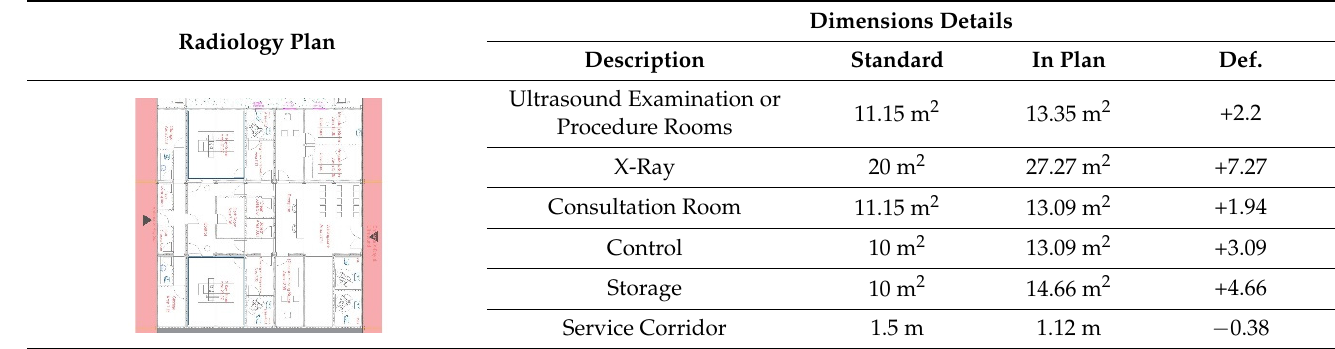
Table 6. Dimensional requirements of the radiology department compared to standards.